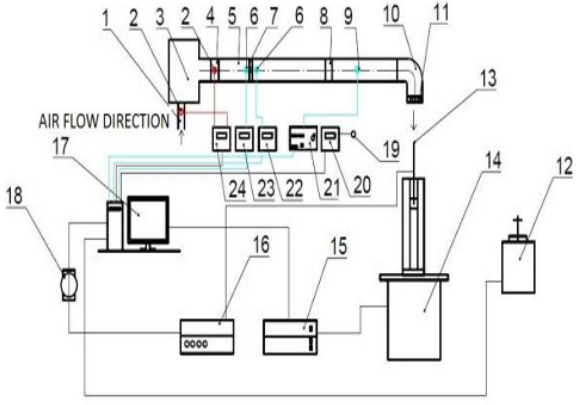
Fig. 1. The scheme of the experimental stand [10]